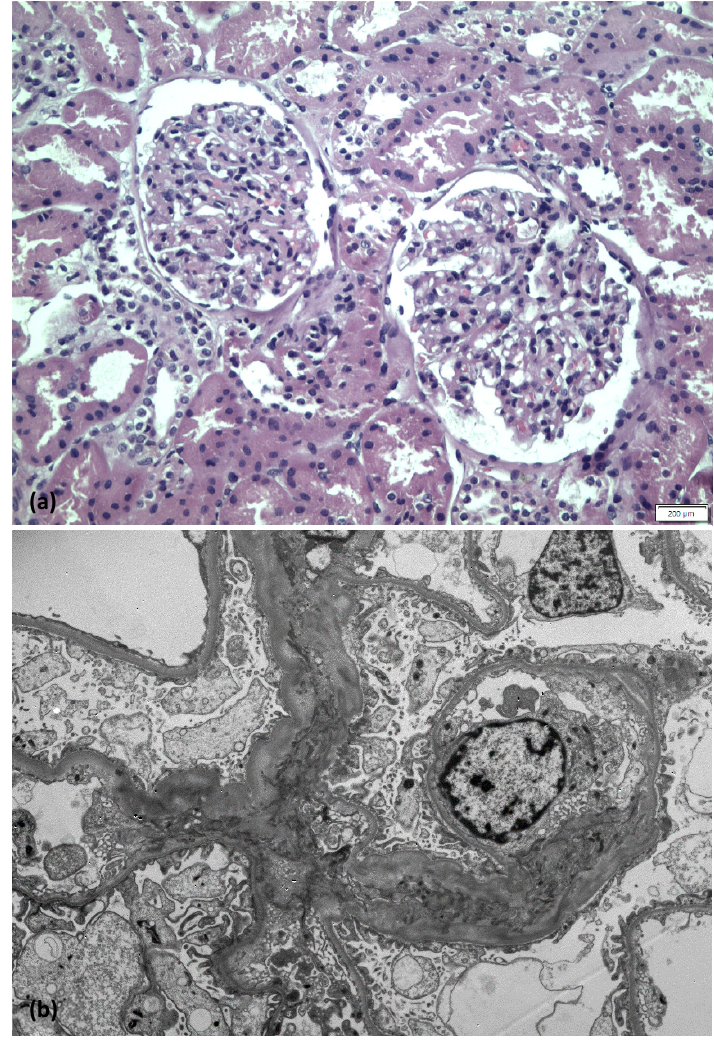
Figure 2. Images from light microscope ( a ), electron microscope ( b ).